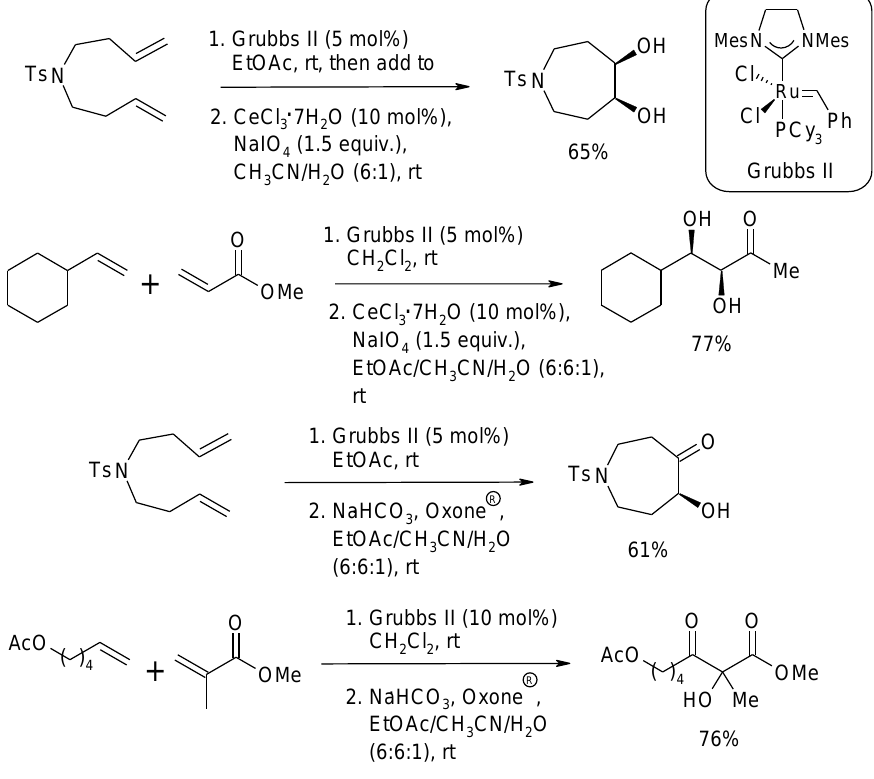
Scheme 6. RCM or CM/dihydroxylation and RCM or CM/α-ketohydroxylation protocols developed by Snapper and co-workers